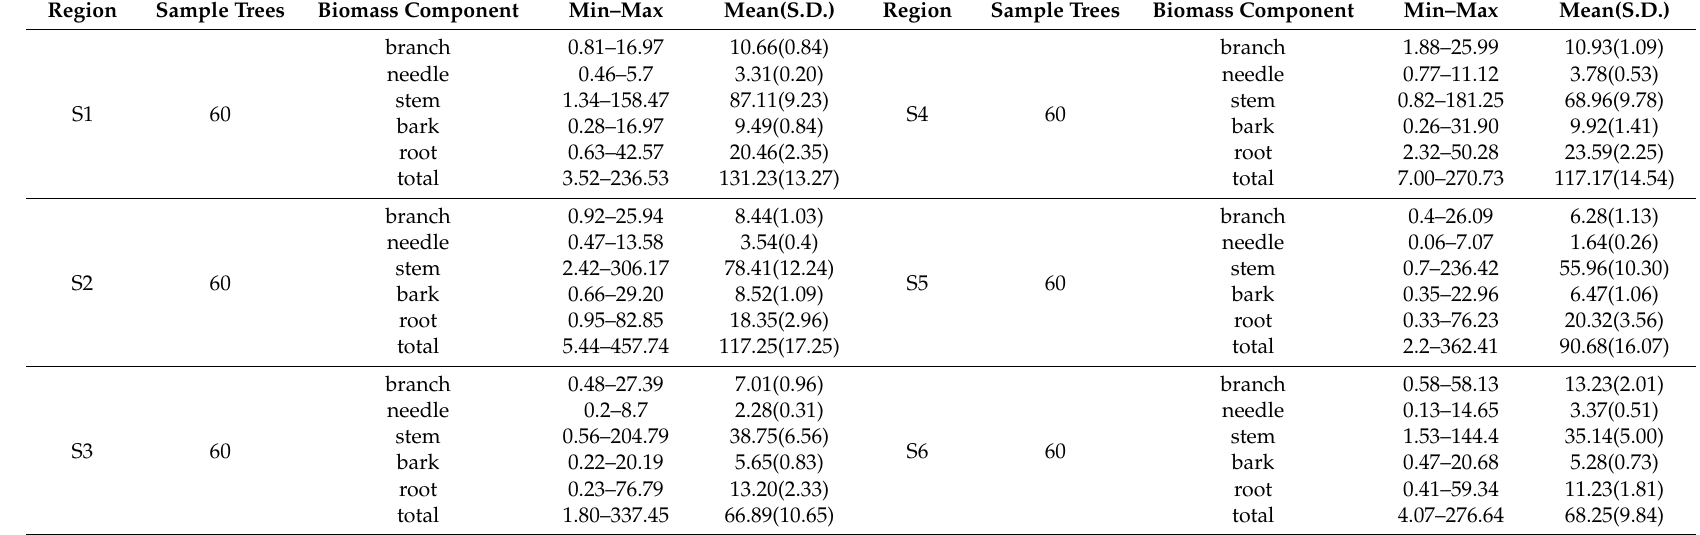
Table 2. Biomass of each larch component (kg tree − 1 ) in six regions in